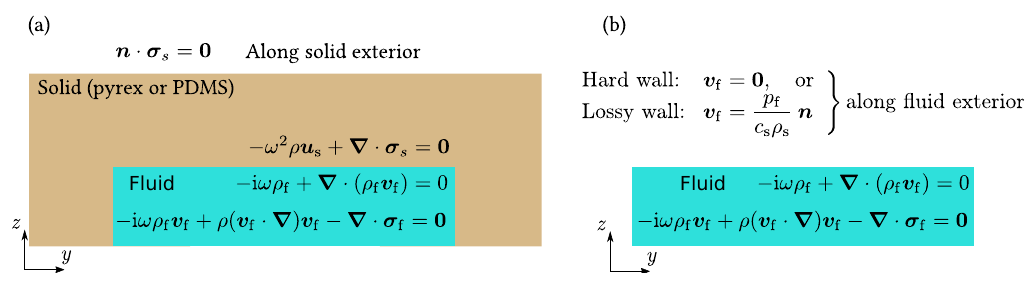
Figure 5. Sketches of the models used in the study. ( a ) The full model with a solid domain (pyrex or PDMS) and a fluid domain (water); and ( b ) the reduced model with only a fluid domain with boundary conditions (hard or lossy) representing the surrounding solid (pyrex or PDMS,